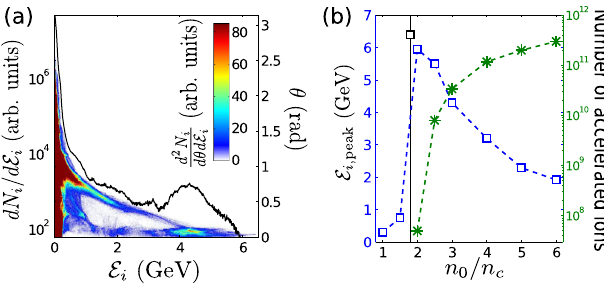
FIG. 5. 3D-PIC simulation results. (a) Ion energy spectrum (black line) and angular-spectrum distribution (color scale) at time 246 fs for the simulation displayed in Fig. 4. (b) Peak ion energy E i; (blue squares) and numbers of accelerated ions peak (green asterisks) for different initial plasma densities and laser amplitude a 0 ¼ 155 , same as in Fig. 4. The black solid vertical line and black square mark the threshold density and the corresponding ion energy as obtained from Eqs. (1) – (3). For 1 n 1 . 5 n c and c , the maximum energies are plotted since there are no spectral